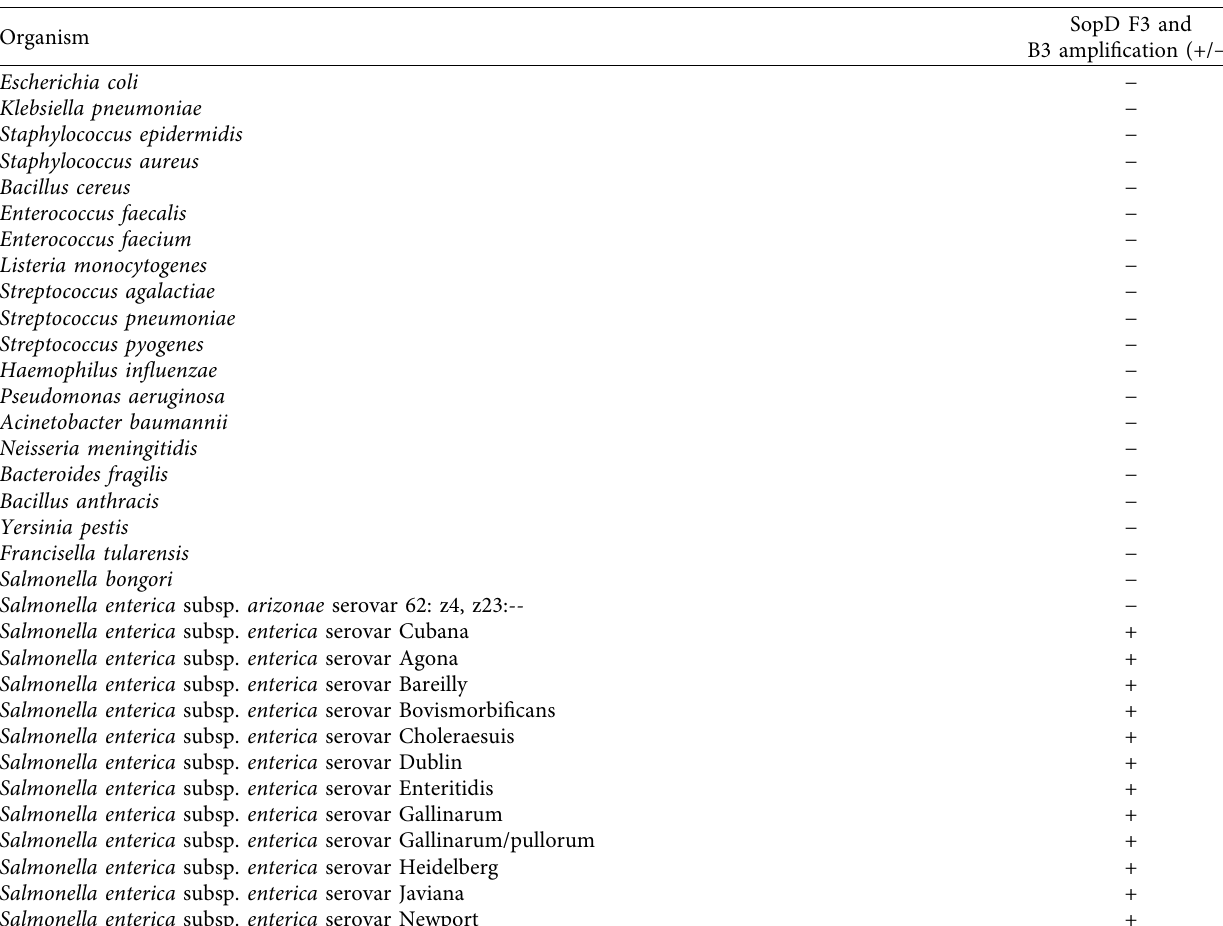
Table 4: In silico PCR amplifcation of SopD F3 and B3 primers. In silico PCR amplifcation was done against diferent bacterial genomes using a freely available molecular biology resource for experiments (http://insilico.ehu.es/). Interpretation of results are as follows: (+) – Amplifcation was observed, ( − ) – No amplifcation was